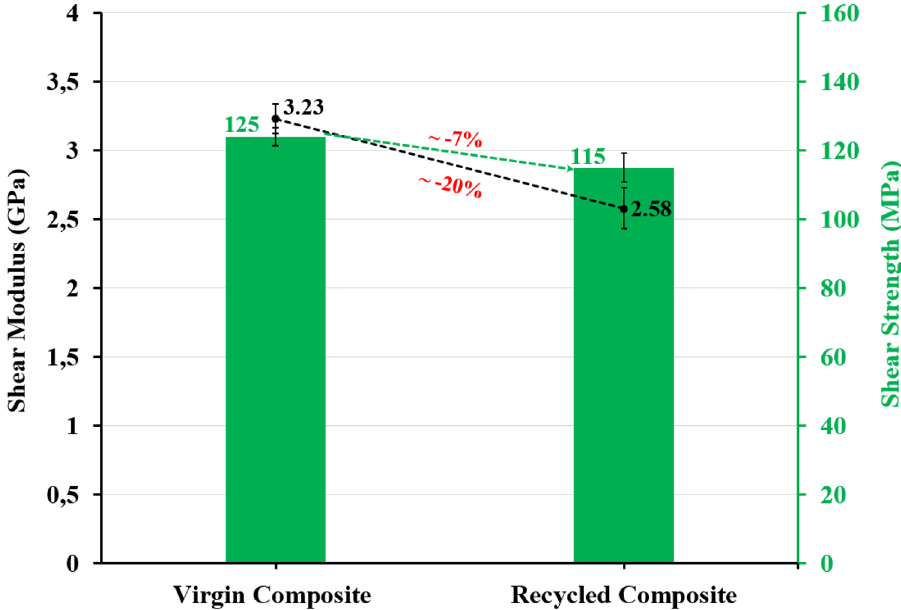
Figure 11. Shear strength and shear modulus evaluations of virgin and recycled composite specimens.